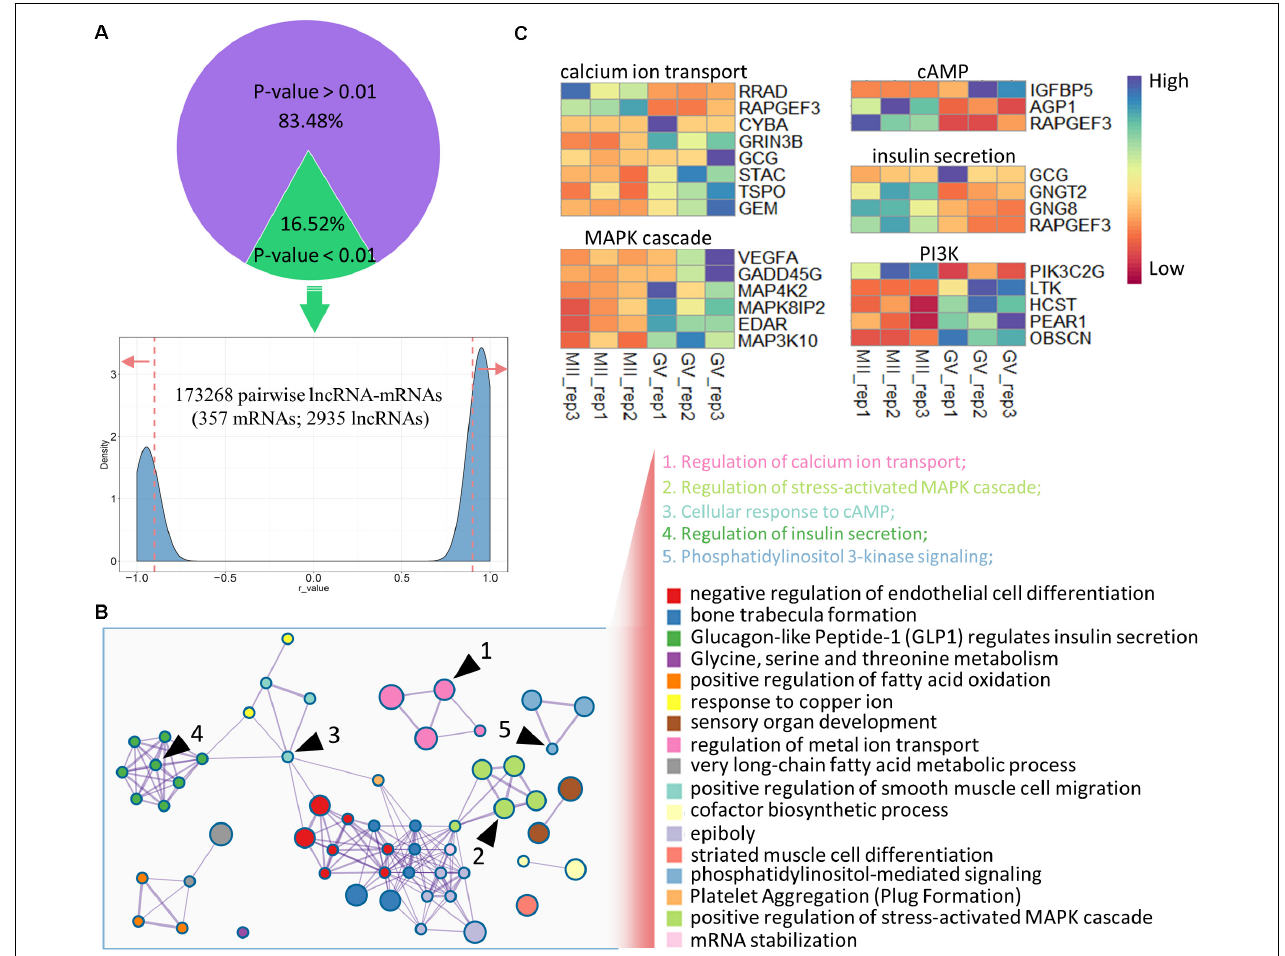
FIGURE 3 | Co-expression analysis of DELs and DEGs in ovine oocytes. (A) Identification of pairwise lncRNA–mRNA in co-expression analysis; the dashed lines mark the r -value (0.9 and –0.9), and red arrows refer to the selected regions with r -values > 0.9 and < –0.9. (B) Functional enrichment analysis of co-expressed genes; similar clusters are annotated with the same color; node size represents gene numbers in term; a line of inter-clusters indicates a common gene; the five reproductive terms are marked with black arrows and labeled with numbers. (C) Heatmap of the expressions of genes enriched in five reproductive terms.